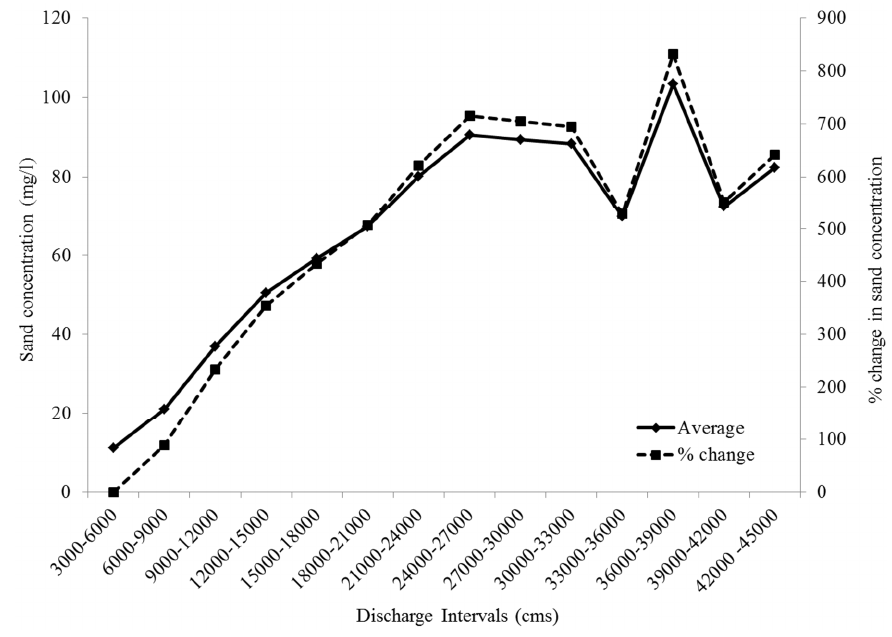
Figure 9. Average sand concentrations and percentage change with each 3000 cms increment of discharge at Tarbert Landing of the LmMR during 1973–2013.